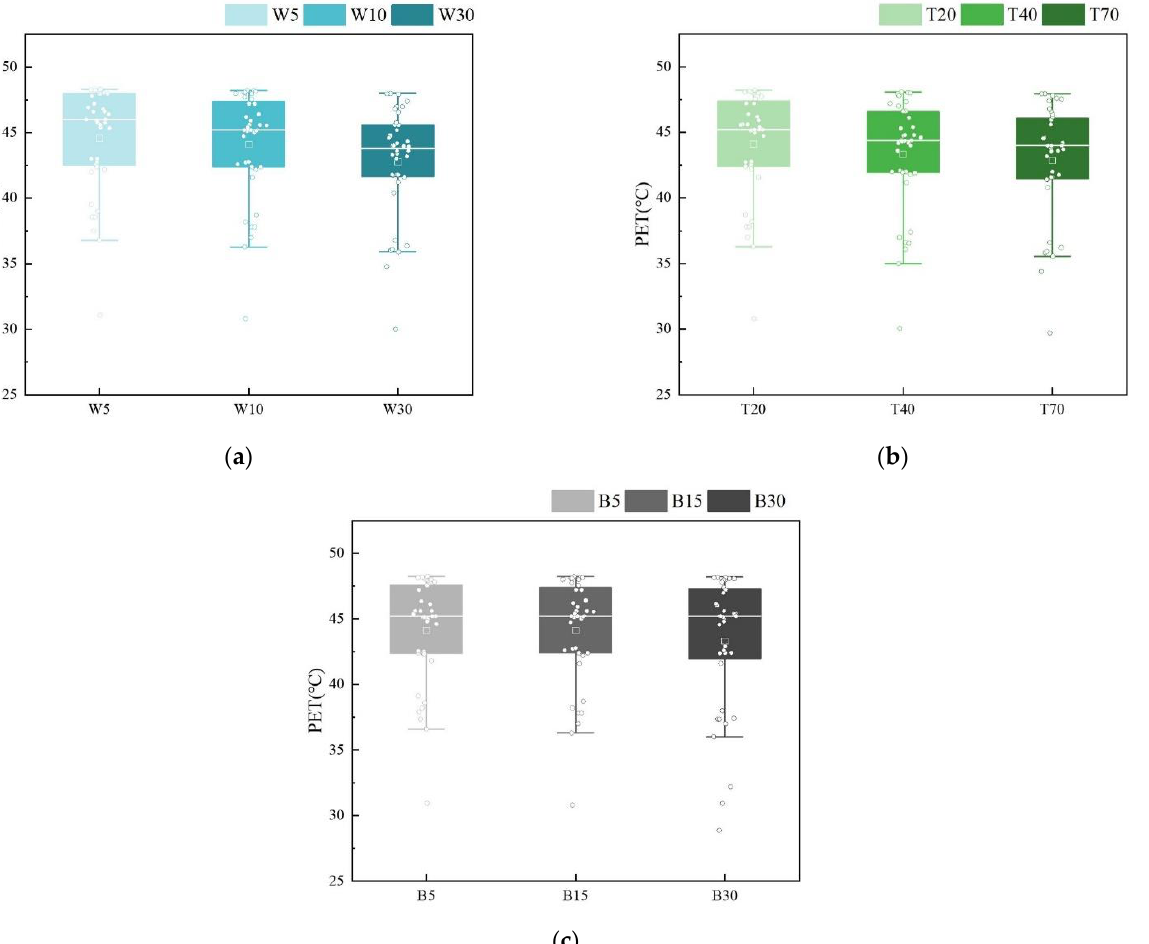
Figure 12. Box plots of PET from 9:00 to 18:00 vs. different quantities of ( a ) water bodies; ( b ) vegetation; and ( c ) buildings.